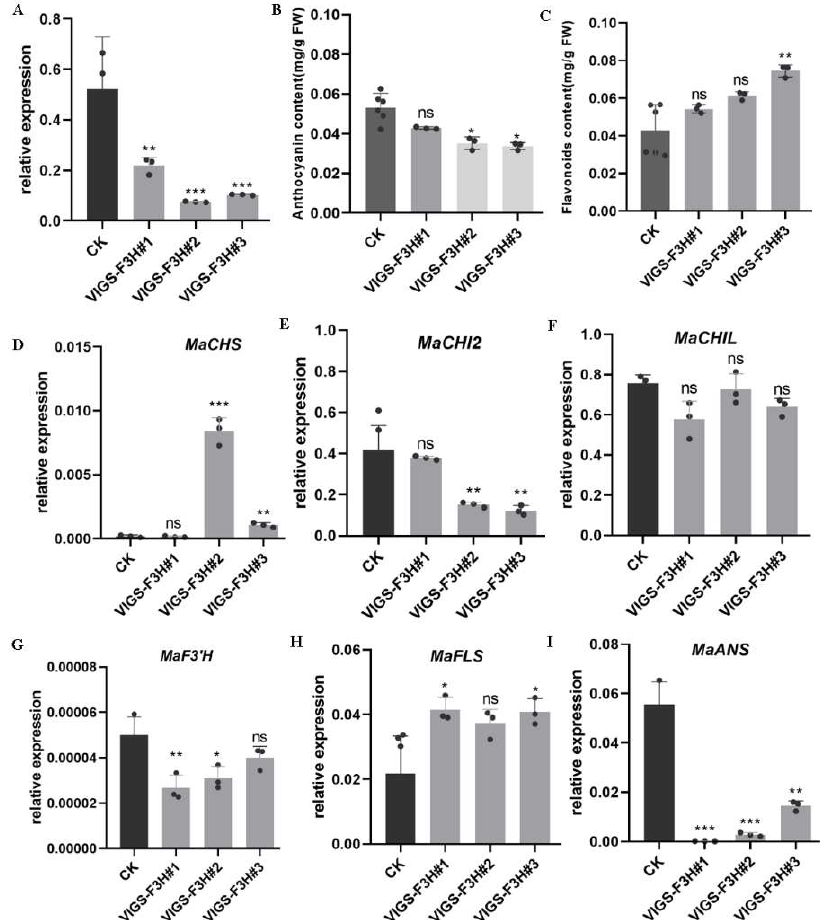
Figure 6. Down-regulation of F3H in mulberry: ( A ) Expression levels of F3H in VIGS transgenic mulberry plants. ( B ) Anthocyanin content in VIGS transgenic mulberry plants. ( C ) Flavonoid content in VIGS transgenic mulberry plants. ( D – I ) The expression levels of genes involved in flavonoid biosynthesis in VIGS transgenic mulberry plants. (* p < 0.05, ** p < 0.01, *** p < 0.001).